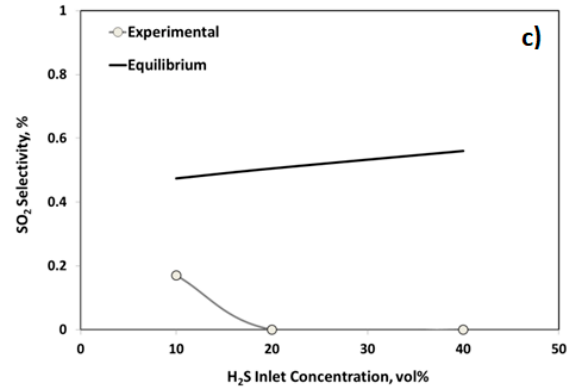
Figure 5. Effect of H 2 S inlet concentration on H 2 S conversion ( a ), H 2 yield ( b ), SO 2 selectivity ( c ) (T = 1100 °C, τ = 30 ms).